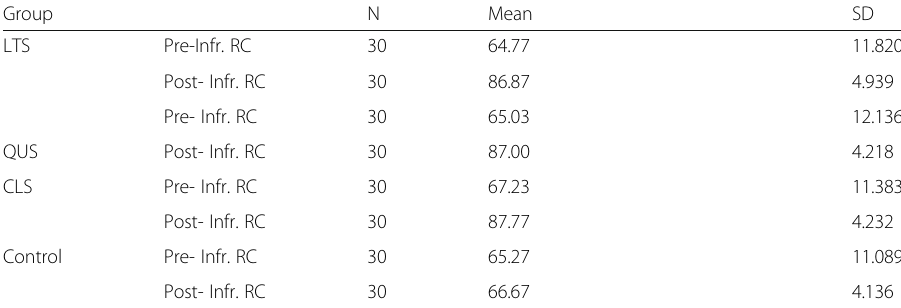
Table 5 Comparison of Inf. RC on pretest and posttest Group N Mean SD LTS Pre-Infr. RC